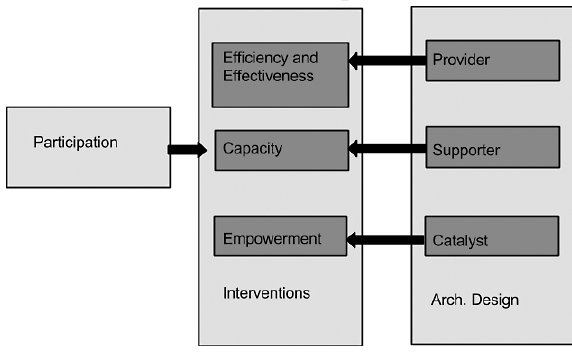
fig. 2. architecture of Empowerment